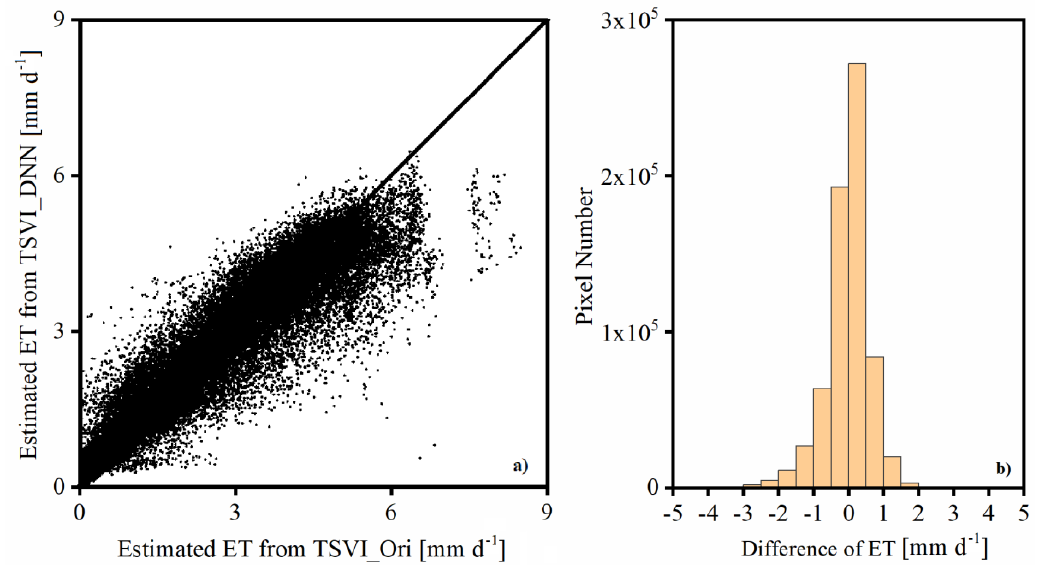
Figure 5. Comparison of ET estimates from the TSVI_DNN and TSVI_Ori model on the regional scale. ( a ) A scatterplot of regional ET estimates from TSVI_DNN vs. those from TSVI_Ori; ( b ) a histogram of the difference between ET estimates from the TSVI_DNN and TSVI_Ori models.